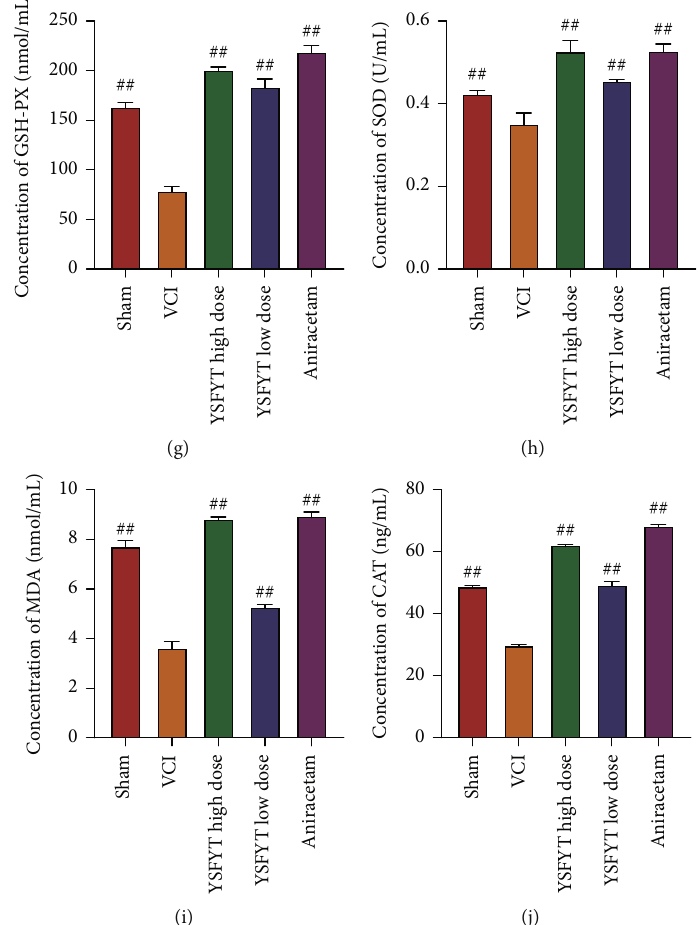
Figure 4: Biochemical index detection of rats. (a – e) LPL, TC, TG, LDL-C, and HDL-C detection of serum by blood biochemical analyzer. (f – j) T-AOC, GSH-PX, CAT, MDA, and SOD detection in hippocampus by ELISA. ## p < 0 : 01